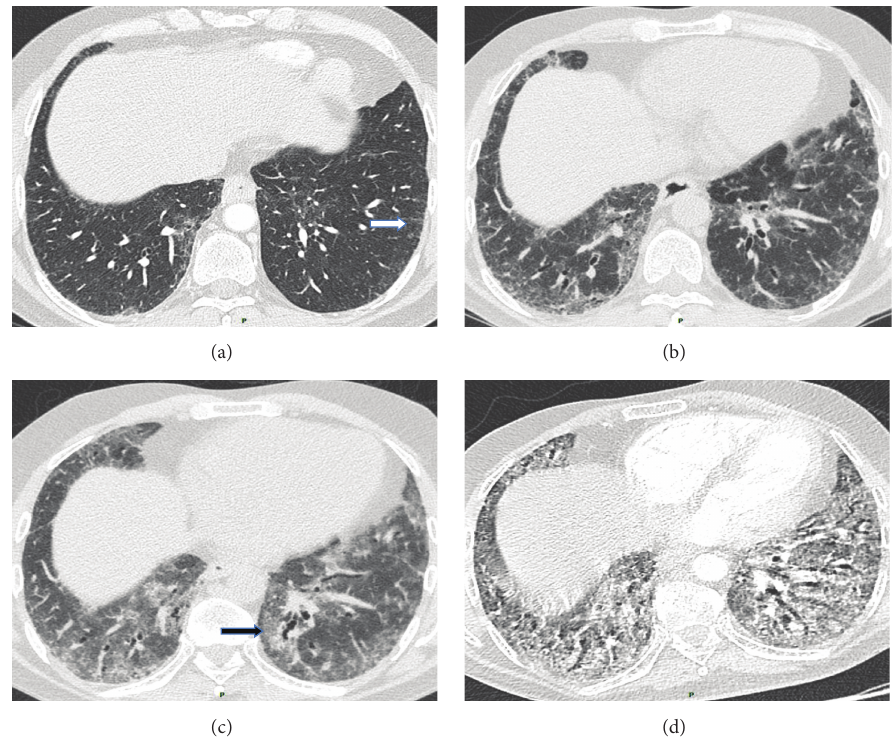
Figure 1: (a) HRCT in 2007 showed slight subpleural lines (arrow). (b) HRCT in March 2012 showed a predominance of subpleural reticular abnormalitieswithsomegroundglassfeatures.(c)HRCTinJuly2012showedaworseningofreticularfeatureswithnewgroundglassopacities (arrow). (d) HRCT in August 2012 showed diffuse ground glass opacities with traction